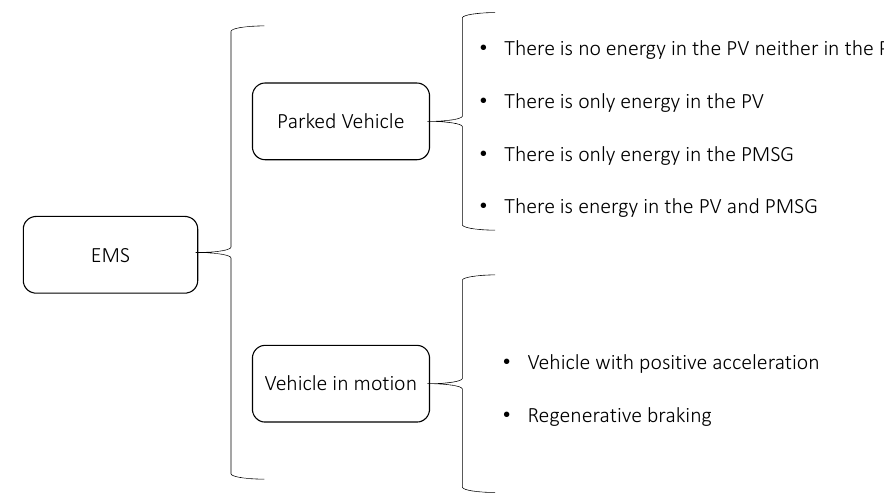
Figure 11. Cases taking into account for the implementation of the EMS.